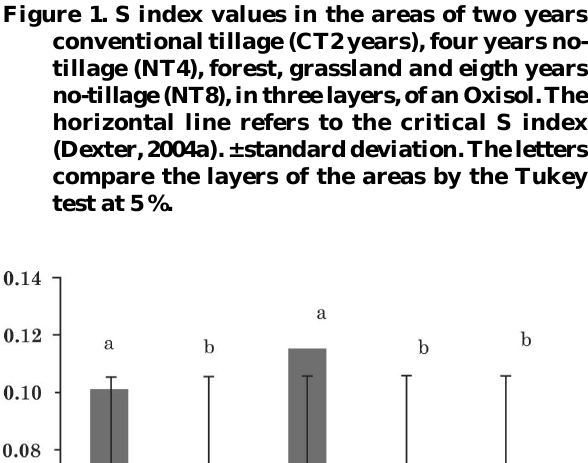
Figure 4. Index S as a function of OM contents in some soil management systems. (n = 105; * the adjusted model is significant at p <0.05 by the F test).